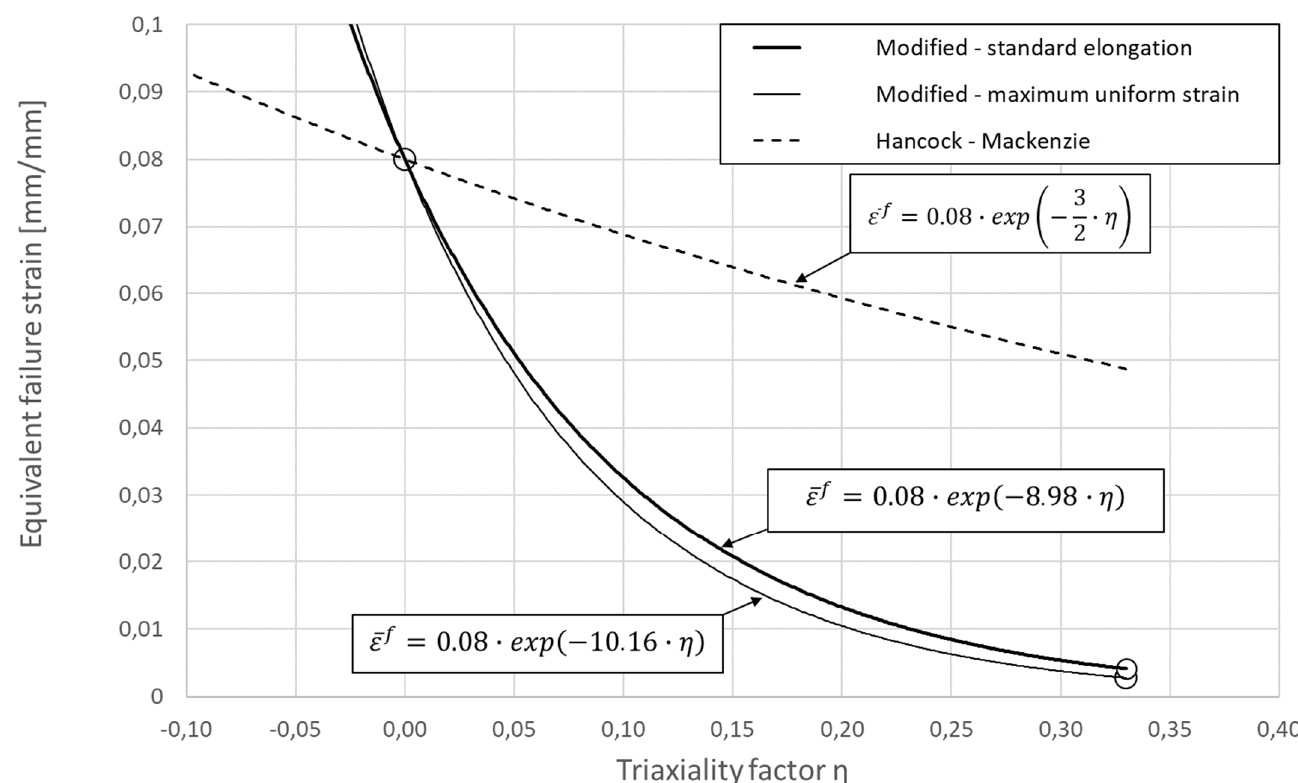
Figure 4. Calibrated criteria with graphical representation: Hancock–Mackenzie—broken line; modified criterion—solid line.